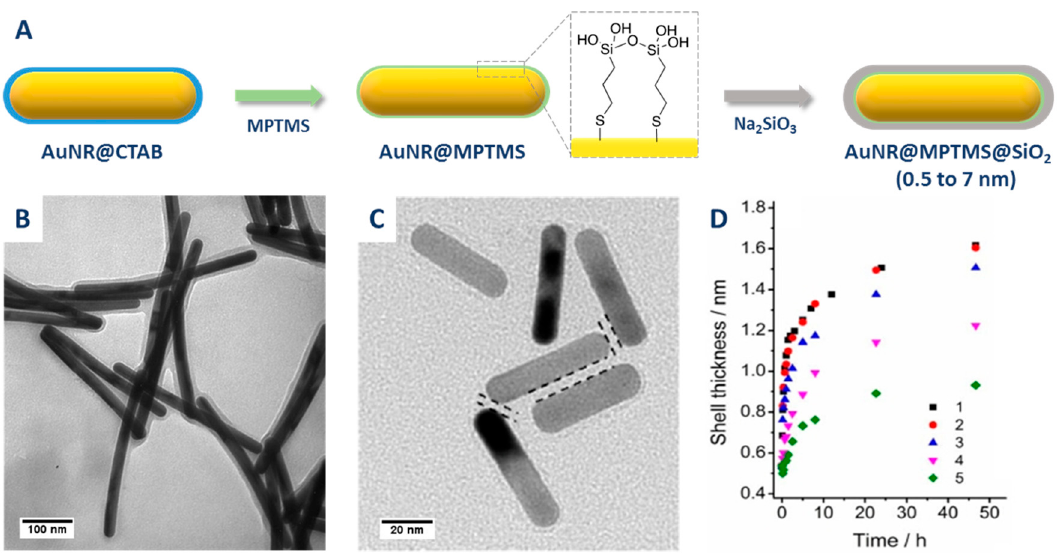
Figure 6. ( A ) CTAB replacement by (3-mercaptopropyl)trimethoxysilane (MPTMS) for the growth of thin layers of silica. ( B ) and ( C ) TEM images obtained for different aspect ratio (AR) from ref [67] ( B ) and ref [69] ( C ). ( D ) Kinetics of silica shell thickness for decreasing concentrations of Na 2 SiO 3 from ref